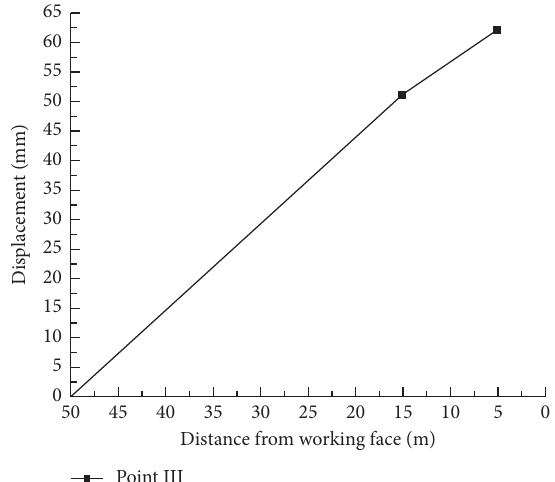
Figure 4: Displacements of roof and floor at Point III of main haulage channel.